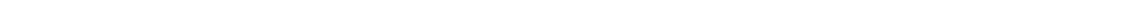
Fig. 3 MAS NMR data for CA – SP1 assemblies. a Expansions of the superposition of 2D 13 C- 13 C correlation spectra for CA and CA – SP1 variants highlighting SP1 resonances and residues exhibiting chemical shift or peak intensity changes. Chemical shift perturbations are present for resonances of